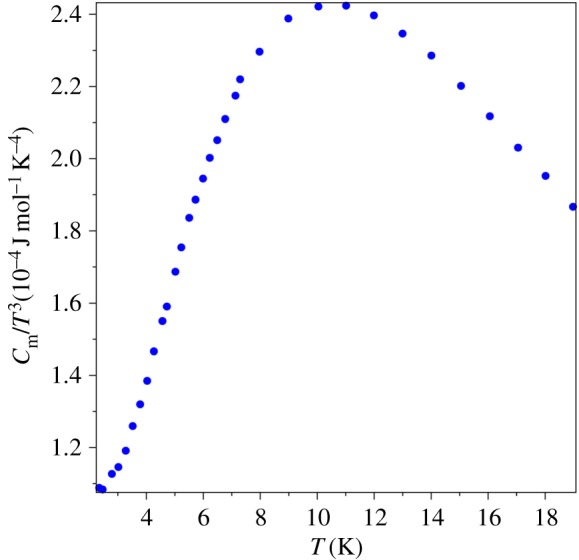
Cm/T3 vs T for vitreous silica [44].